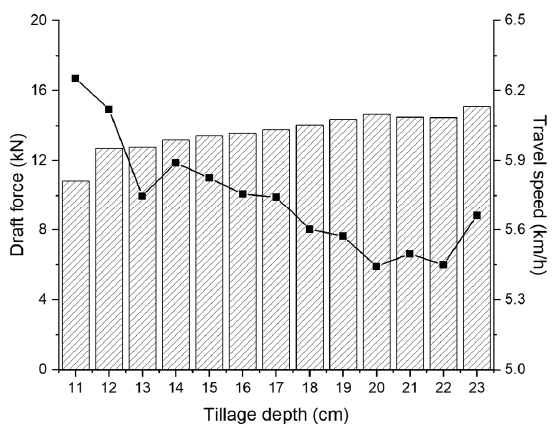
Figure 8. Overall mean draft force according to tillage depth.